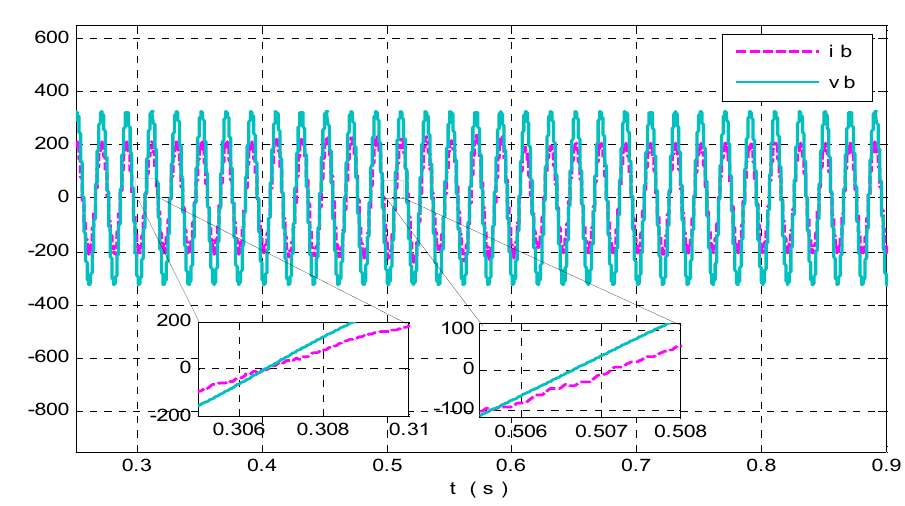
Figure 20. Voltage and current signals (phase a).